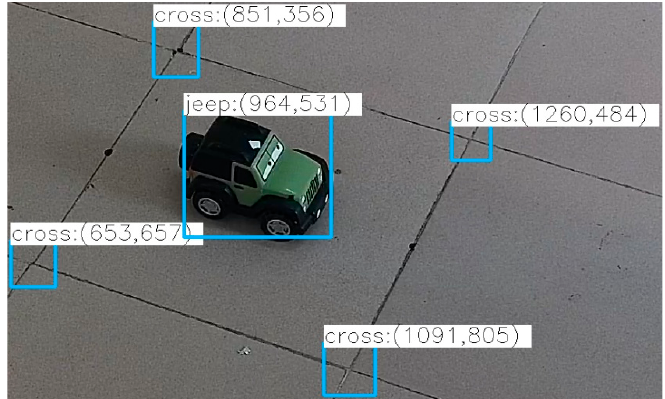
Figure 12. Target detection results with YOLOv4.